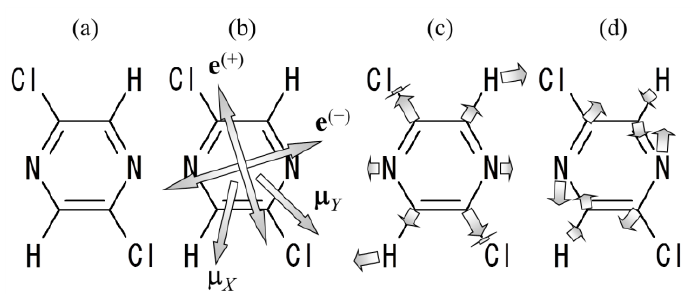
Figure 2. ( a ) Molecular formula of 2,5-dichloropyrazine (DCP). ( b ) Directions of transition moments µ X and µ Y at the ground-state optimized geometry of DCP as well as those of linear polarization vectors e (+) and e ( − ) defined by Equation (31). The angle between e (+) and e ( − ) is 0.48 π . Normal mode vectors of the ( c ) breathing and ( d ) distortion modes are represented by thick arrows. Modified from [56] with permission of the American Chemical Society.